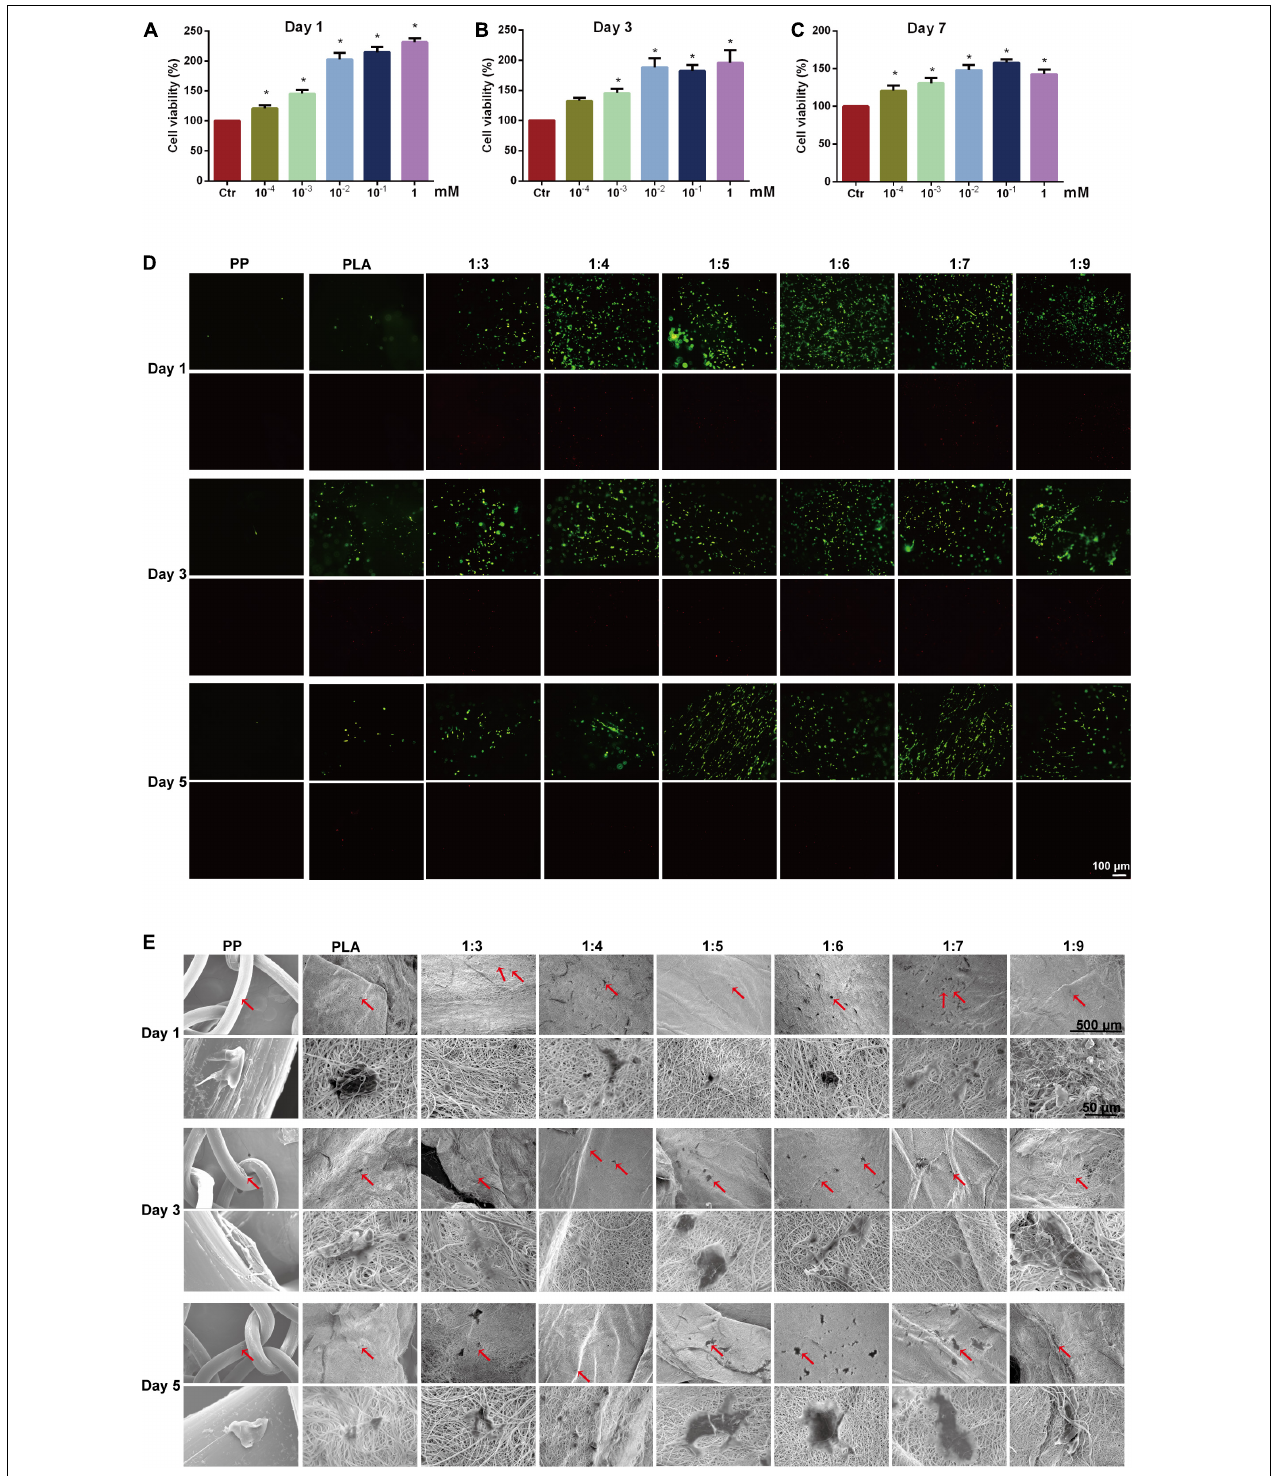
FIGURE 2 | Biocompatibility test of biomimetic scaffolds. Cytotoxicity of PNIPAAm-b-PEG of different concentrations were detected by CCK-8 method on (A) days 1, (B) 3, and (C) 7. (D) Cell viability was assessed by live/dead staining of ADSCs after culture of 5 days, in which live cells were stained in green and dead cells were stained in red (Scale bar = 100 µ m). (E) Cellular morphology of ADSCs (in red arrows) seeded in scaffolds was observed via scanning electron microscopy after 1, 3, and 5 days of culture. * P < 0.05 vs. the control group.